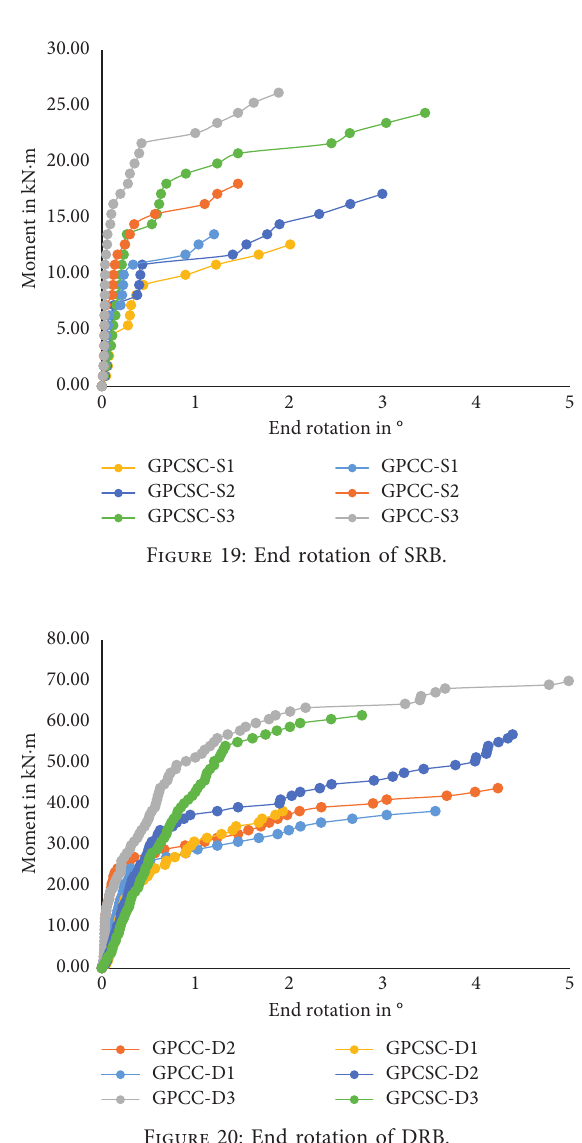
Figure 20: End rotation of